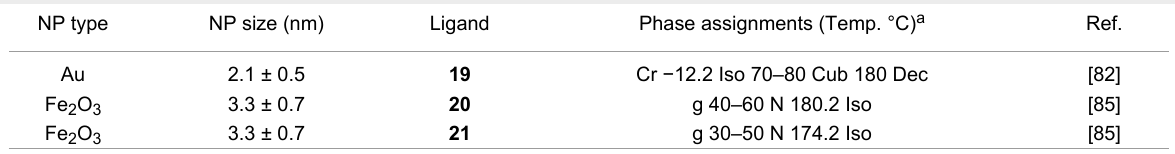
Table 3: Summary of the phase behaviour of the hybrid NPs with dendritic and proto-dendritic ligands discussed in the text. NP type